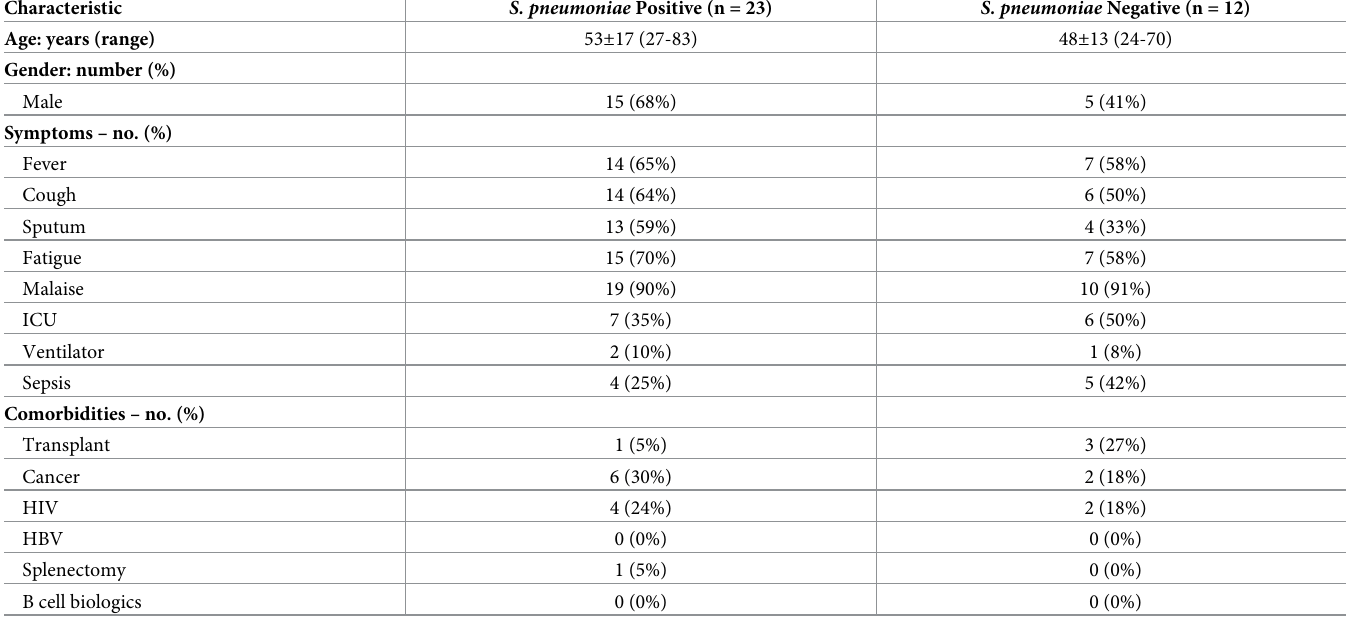
Table 1. Demographic and clinical information for infected